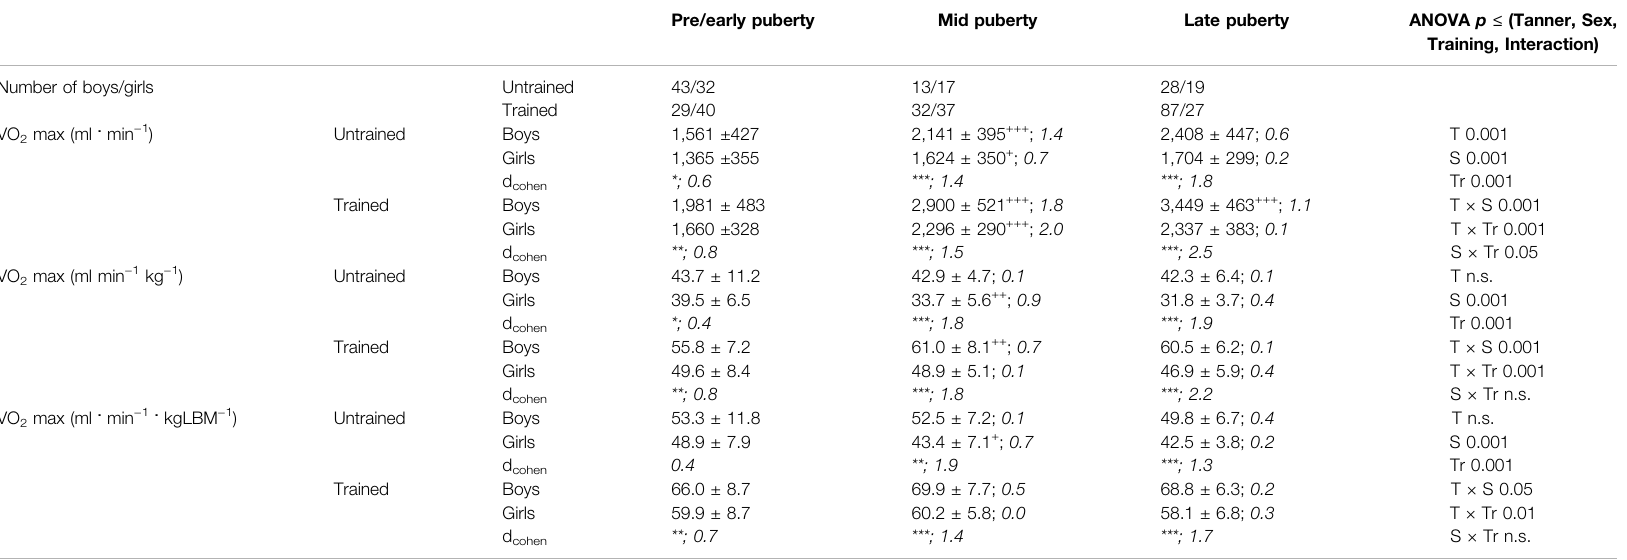
TABLE 5 | VO 2 max in trained and untrained boys and girls in different stages of sexual maturation.